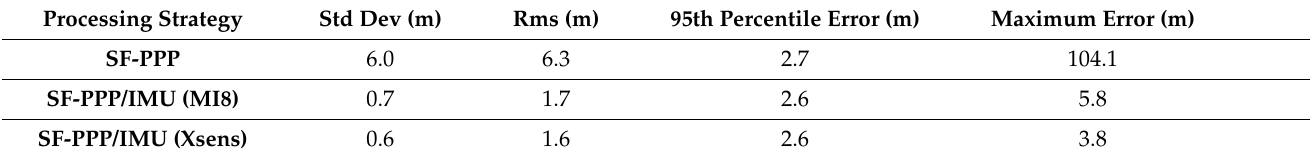
Table 3. Horizontal errors with different sensor fusion combinations for single-frequency PPP processing.